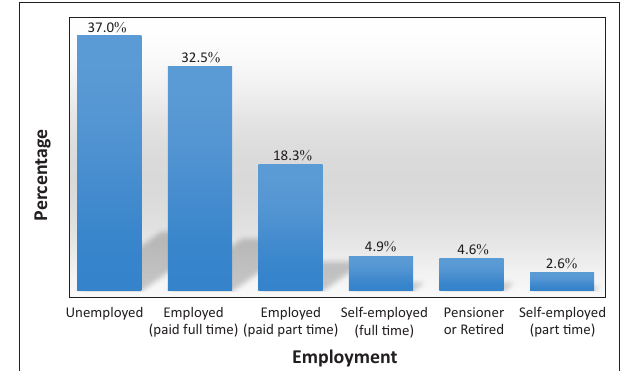
FIGURE 3: Respondents’ employment profile.